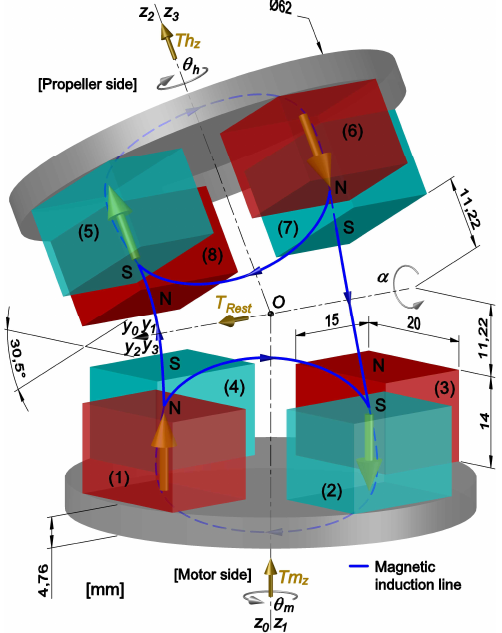
Figure 2. Flat-RMCT model. Configuration with α max , θ m = θ h = 0 ◦ .